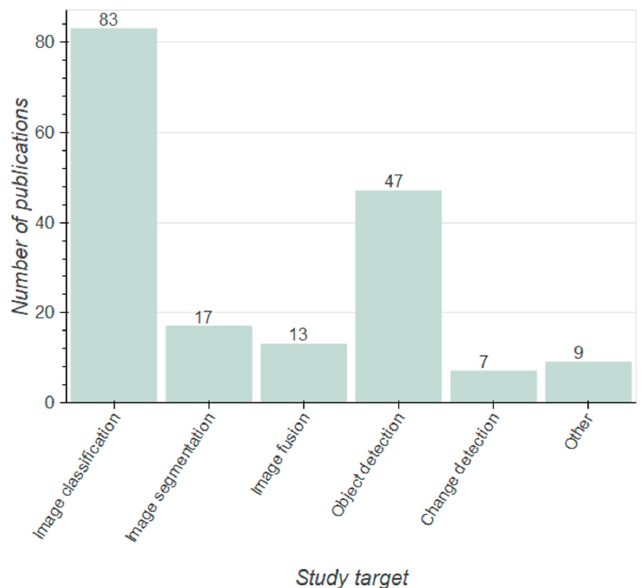
Figure 8. The number of publications for different study targets.